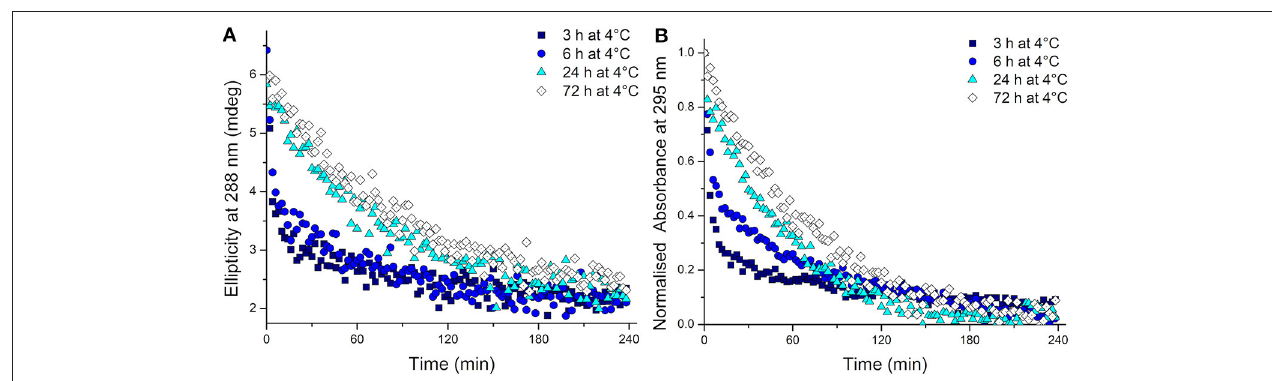
Frontiers in Chemistry |